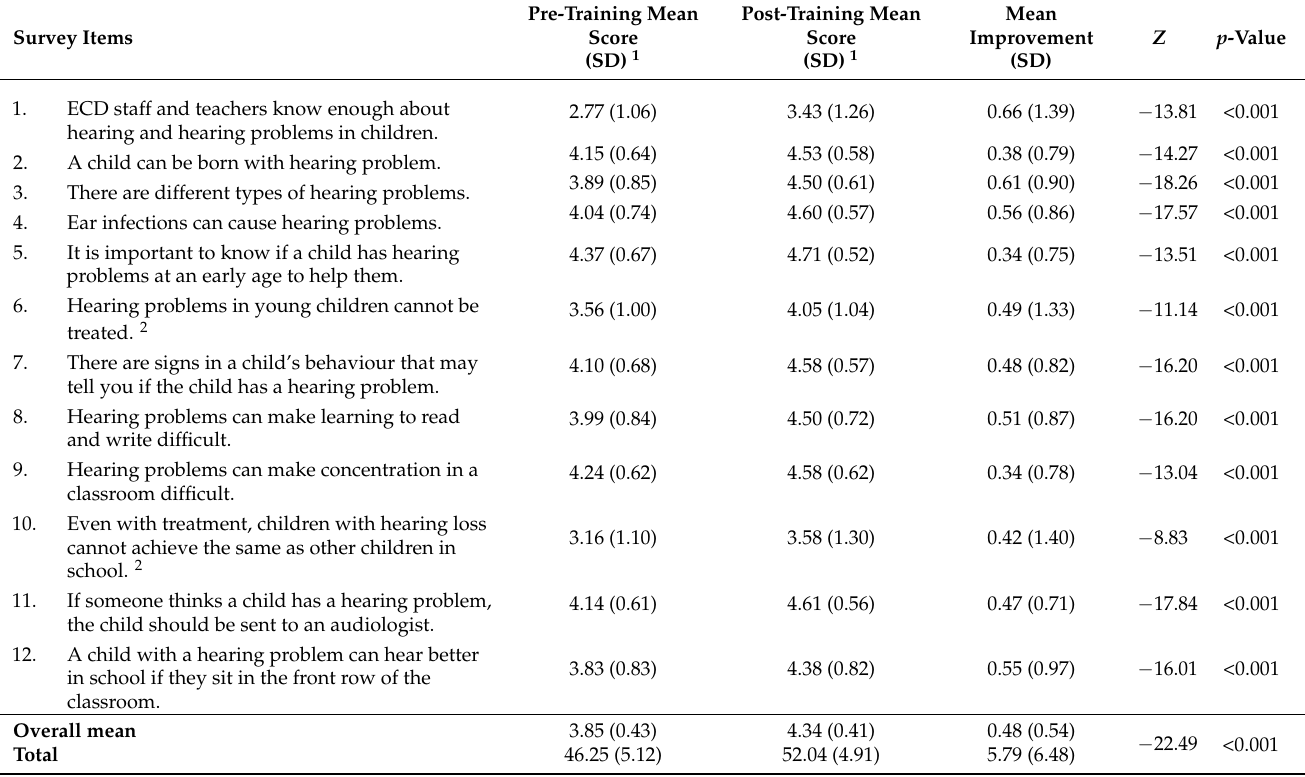
Table 3. Descriptive statistics, the z -test statistic and the corresponding p -values of the pre-post test scores of ECD practitioners ( n = 1012).